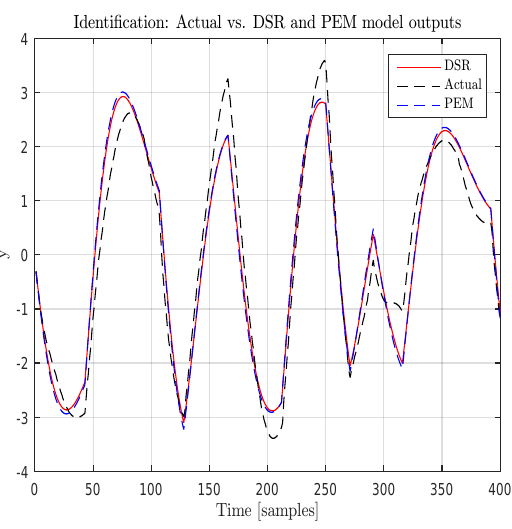
Table 4: Example